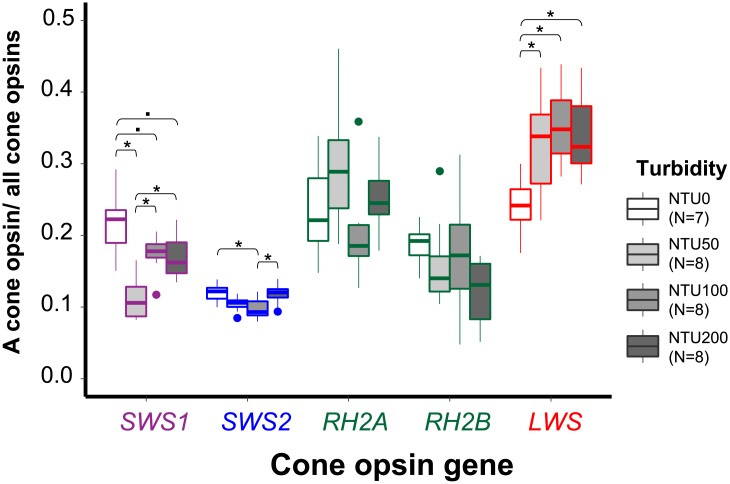
Box plot showing the median (—), 25th and 75th percentiles (box), 95% range (|), and outliers (•) of cone opsin proportional expression values for different turbidity treatments.An asterisk indicates P < 0.05 (one-way ANOVA, post hoc Tukey’s comparisons) and a dot indicates 0.10 > P > 0.05 (one-way ANOVA, post hoc Tukey’s comparisons). The color of the boxes of each opsin family represents its general λmax range. SWS1’s is ultraviolet light, SWS2’s is blue light, RH2’s is green light, and LWS’s is red light.